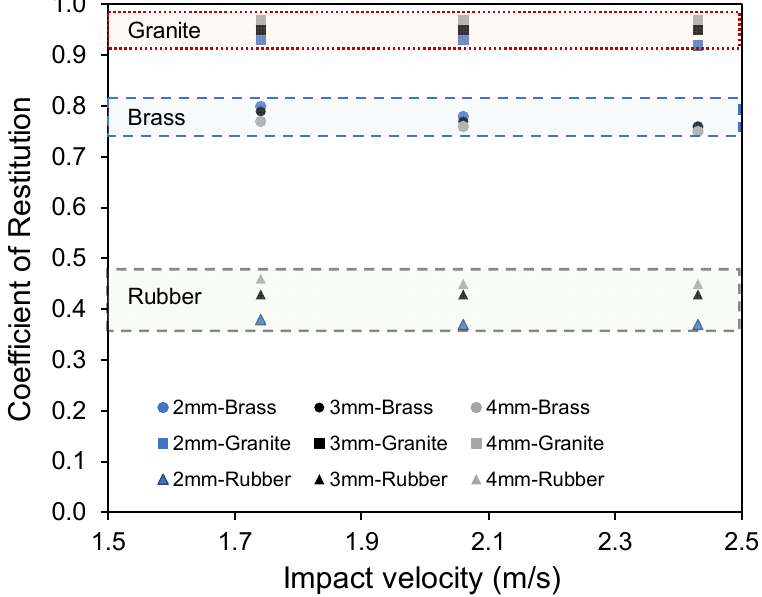
Figure 5. The average values of the coefficient of restitution for 2, 3 and 4 mm sized glass balls impacting on various base blocks.